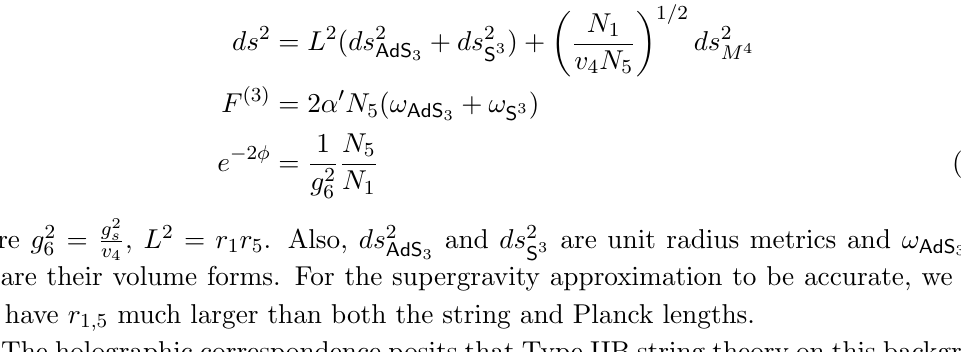
Table 3 . Brane con(cid:12)guration generating a class of defects. near-horizon metric